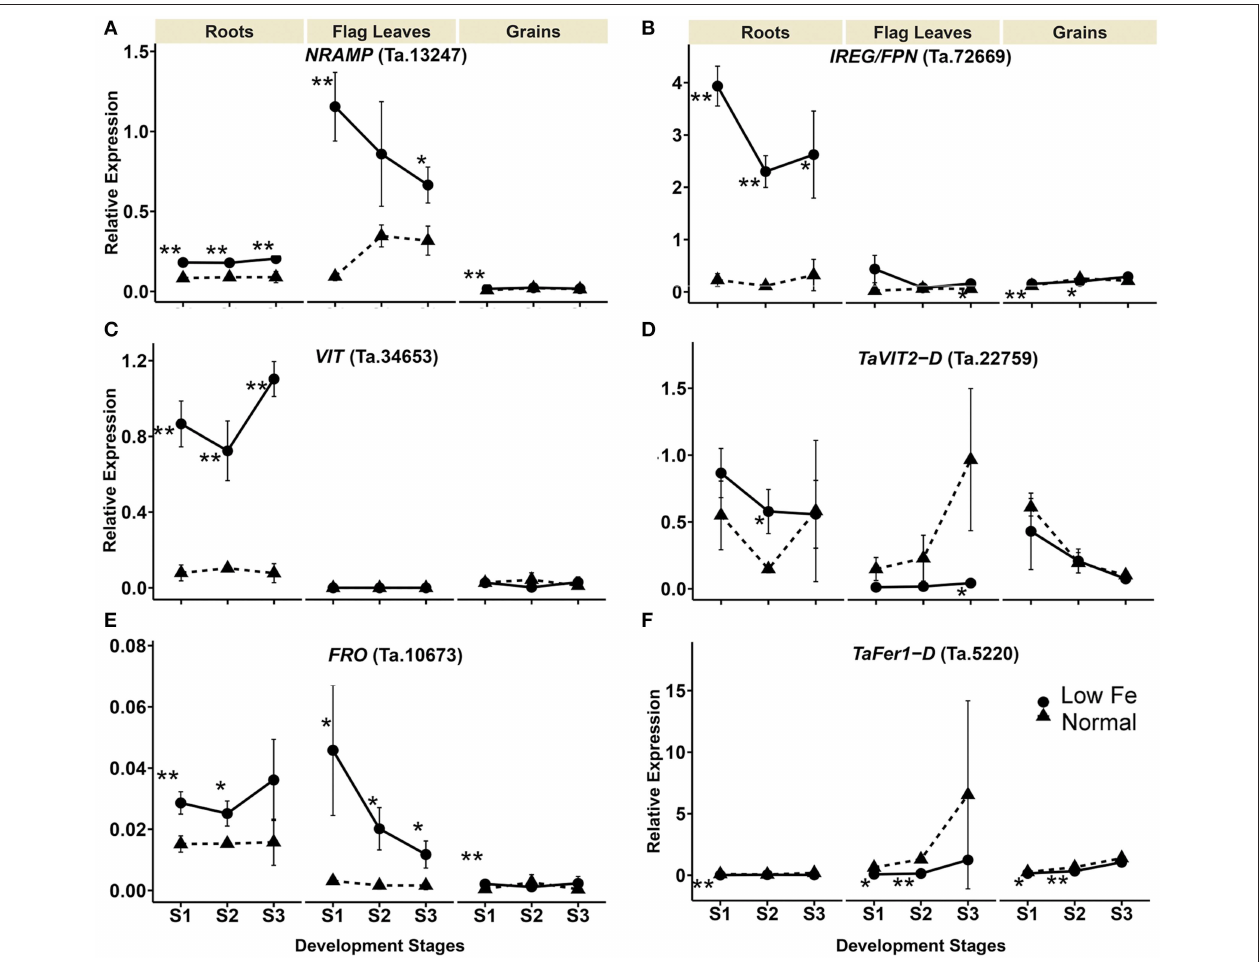
FIGURE 4 | Differentially expressed wheat homologs of intracellular iron transporters and storage proteins encoding genes under iron deficiency. The data collected at three different development stages, i.e., 8–10 DPA (stage 1), 25–28 DPA (stage 2), and 33–35 DPA (stage 3) are presented. Values are the mean ± standard deviation of the three biological replicates (* p ≤ 0.05; ** p ≤ 0.01). Note the differences in scale at Y-axis for relative expression levels of tested genes. (A) NRAMP (Ta.13247), (B) IREG / FPN (Ta.72669), (C) VIT (Ta.34653), (D) TaVIT2 -D (Ta.22759), (E) FRO (Ta.10673), (F) TaFer1 - D